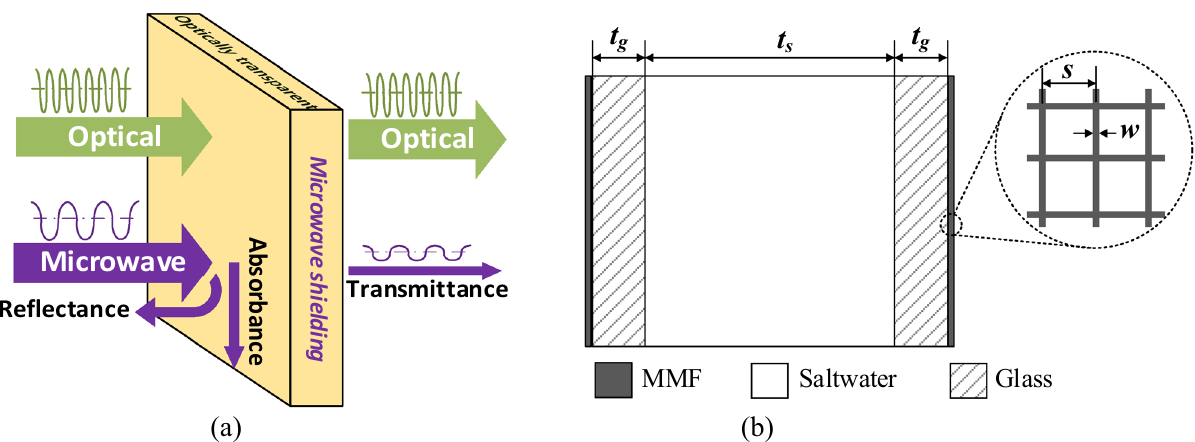
Figure 1. ( a ) Schematic diagram of the EMP shielding window; ( b ) geometry of the MMF/glass/saltwater/ glass/MMF